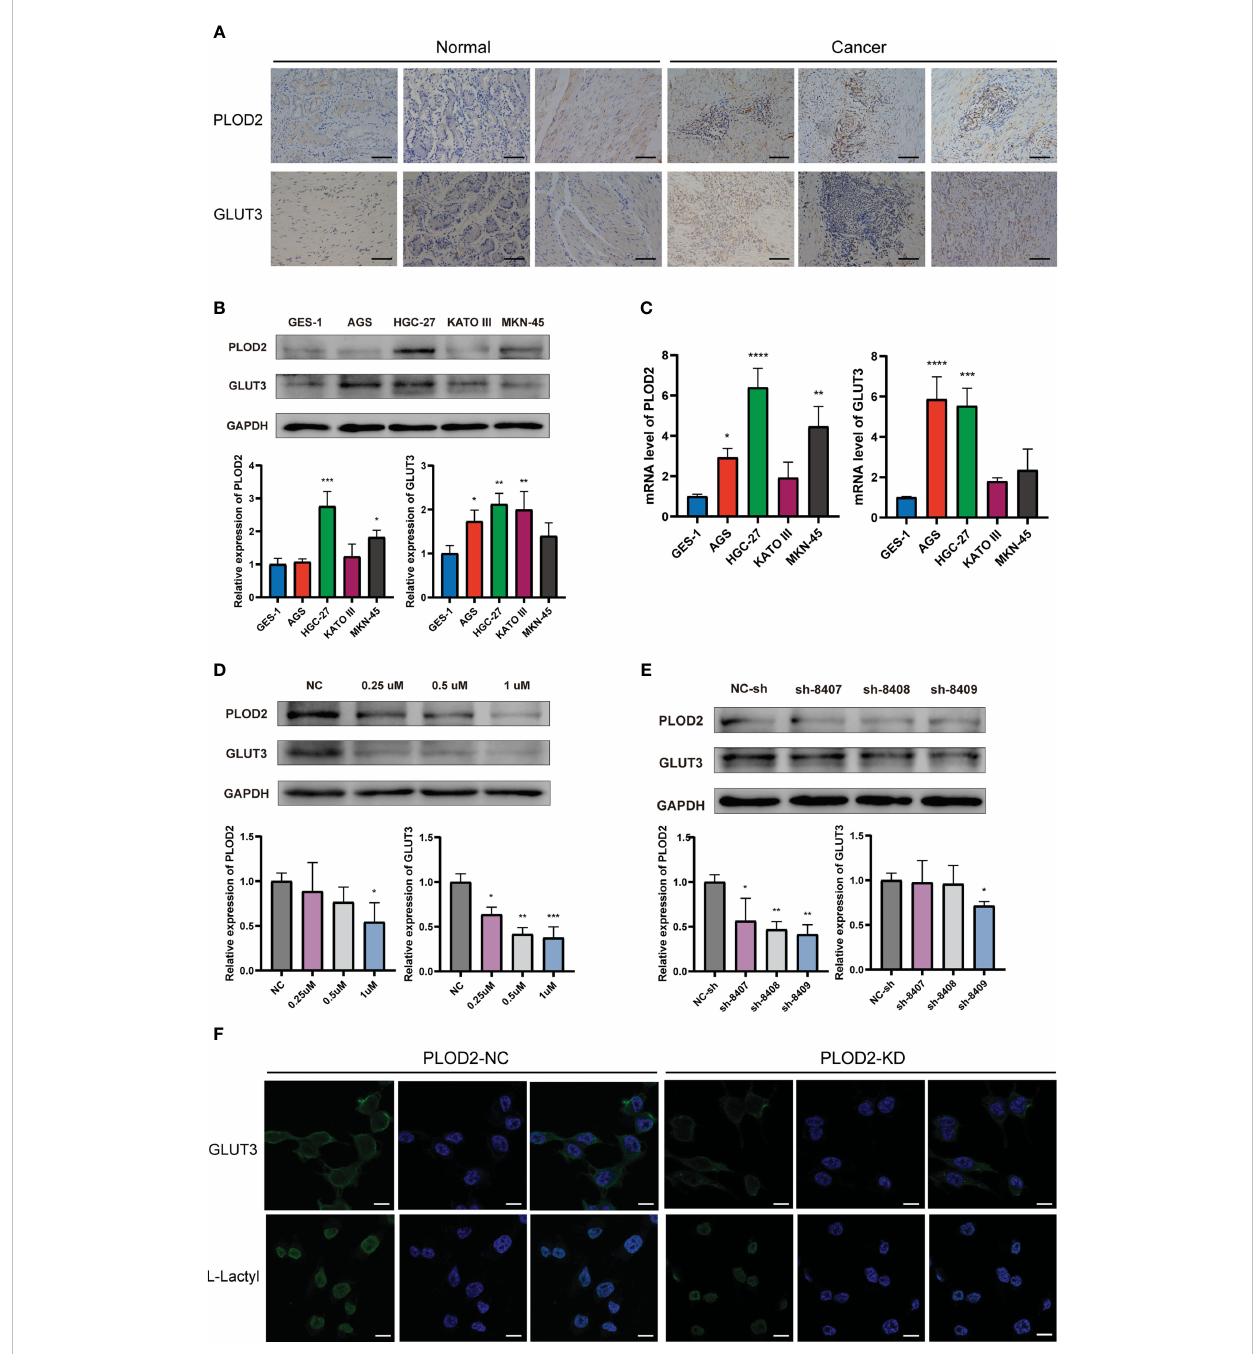
FIGURE 7 Expression of PLOD2 and GLUT3 in GC cell lines and GC tissues. *p<0.05; **p<0.01; ***p<0.001; ****p<0.0001. (A) Immunohistochemistry for PLOD2 and GLUT3 in normal gastric tissues and GC tissues. Scale bar, 100 µm. (B) Western blots for PLOD2 and GLUT3. (C) PCR results of PLOD2 and GLUT3. (D) Western blots of HGC cells treated with different concentrations of lactate dehydrogenase inhibitors (0.25 µM, 0.5 µM, and 1 µM). (E) Western blots after transfection with the PLOD2-KD plasmid. (F) Expression levels of GLUT3 and L-Lactyl in PLOD-NC group and PLOD-KD group were compared by immuno fl uorescence. Scale bar, 200